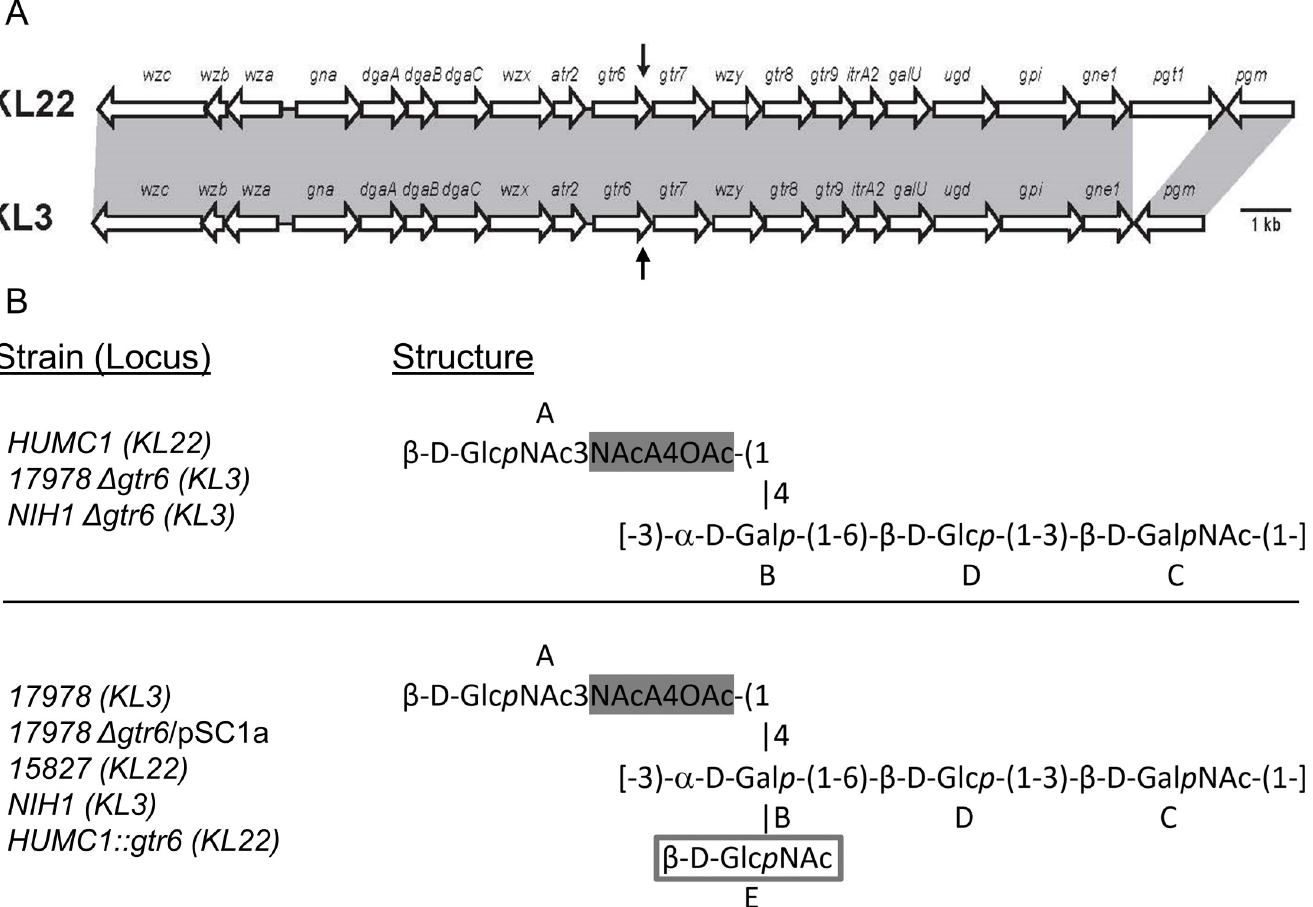
Fig 1. Capsular gene loci for A . baumannii KL3 and KL22 and capsular carbohydrate composition and linkage of KL22, and KL3 capsule locus strains. (A) Whole-genome sequencing of HUMC1 (a hypervirulent strain), 15827 (a hypovirulent strain) and ATCC 17978 (an avirulent strain) revealed distinct capsule loci organized into KL22 (HUMC1 and 15827) and KL3 (ATCC 17978) groups. KL22 differs from KL3 in that it contains an extra acetyltransferase gene pgt1 , while HUMC1 (KL22) contains a transposon insertion sequence disruption in the coding region of the glycotransferase gtr6 (downward black arrow). We then disrupted the gtr6 gene in ATCC 17978 through the insertion of an antibiotic resistance cassette in its coding (upward black arrow), and then by replacing the entire gene with a defective copy from HUMC1. (B) (Top) Structural analysis of hypervirulent HUMC1 and the ATCC 17978 Δ gtr6 mutant (KL3) revealed differential levels of acetylation at the A4 position marked in grey highlight (90% for pgt1 + HUMC1 and 50% for pgt1 - ATCC 17978 Δ gtr6 ). The two strains are isogenic at the capsule locus save for pgt1 . (Bottom) Structural analysis of avirulent ATCC 17978 and hypovirulent 15827 (KL22) revealed the same pgt1 -mediated difference in acetylation as well as an additional GlcNAc branch at position B (grey rectangle). Both KL22 and KL3 loci have a functioning gtr6 gene.